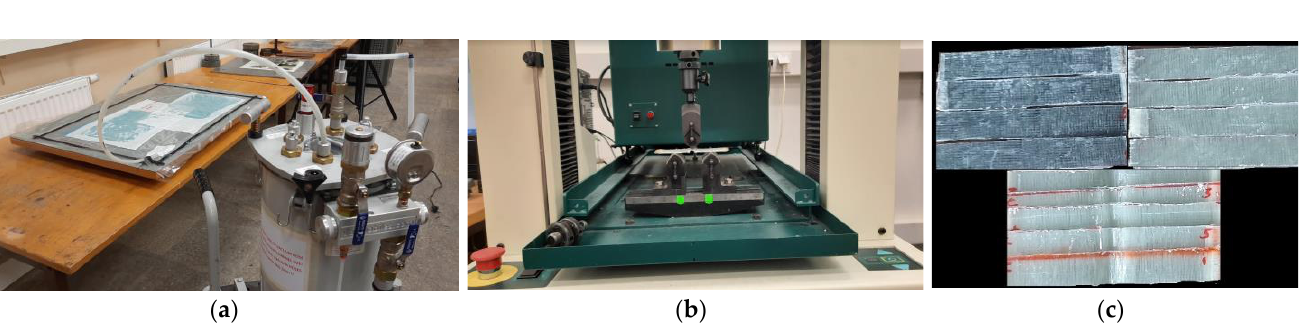
Figure 1. ( a ) Composite panel preparation using the vacuum bagging method. ( b ) Flexural test on a specimen with waviness. ( c ) Specimens for flexural test.